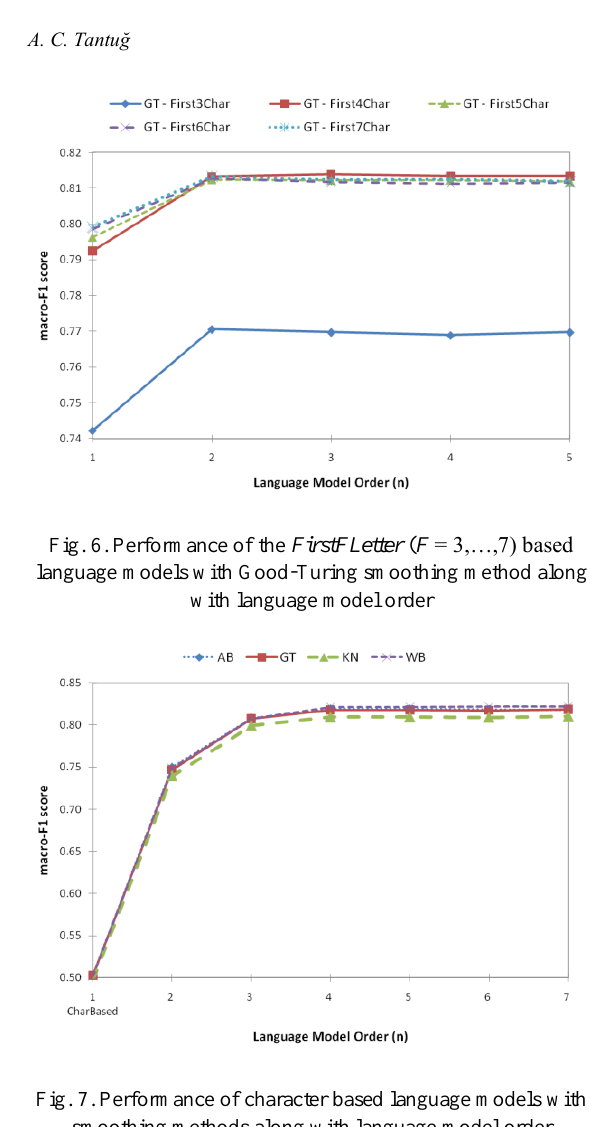
Fig. 7. Performance of character based language models with smoothing methods along with language model order